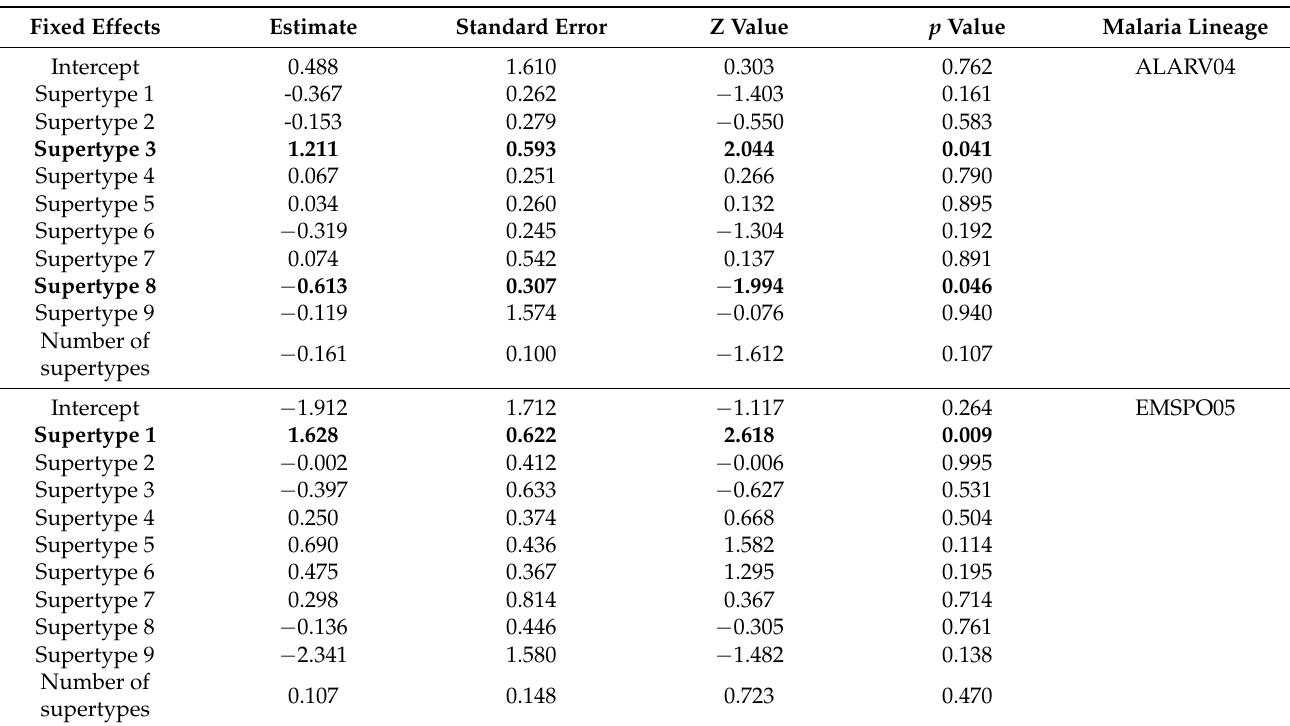
Table 4. The association between MHC variation and malaria lineages. Nominally significant results ( p < 0.05) are marked in